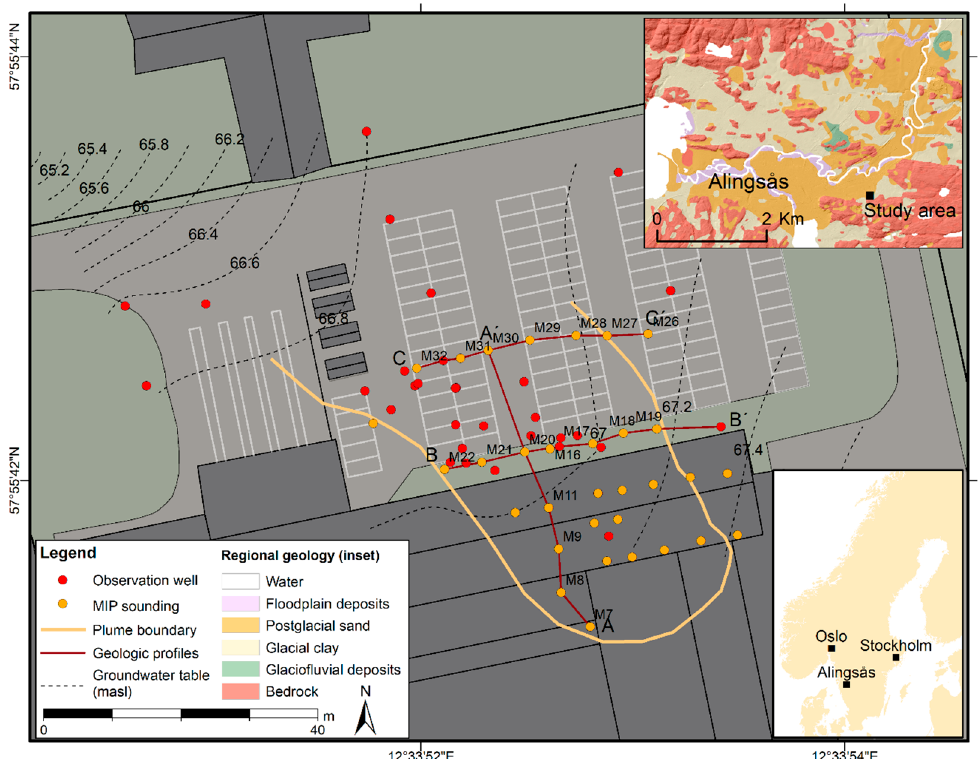
Figure 1. Overview of the Alingsås site where the observation wells (red circles), the Membrane Interface Probe (MIP) soundings (orange circles), the groundwater level (black dashed lines), the plume boundaries (orange line) and the regional surface geology (top right, created with data from SGU Jordarter, 1:25,000–1:100,000 © SGU) can be seen. Line A-A’, B-B’ and C-C’ marks the location of geological profiles shown in Figure 2.